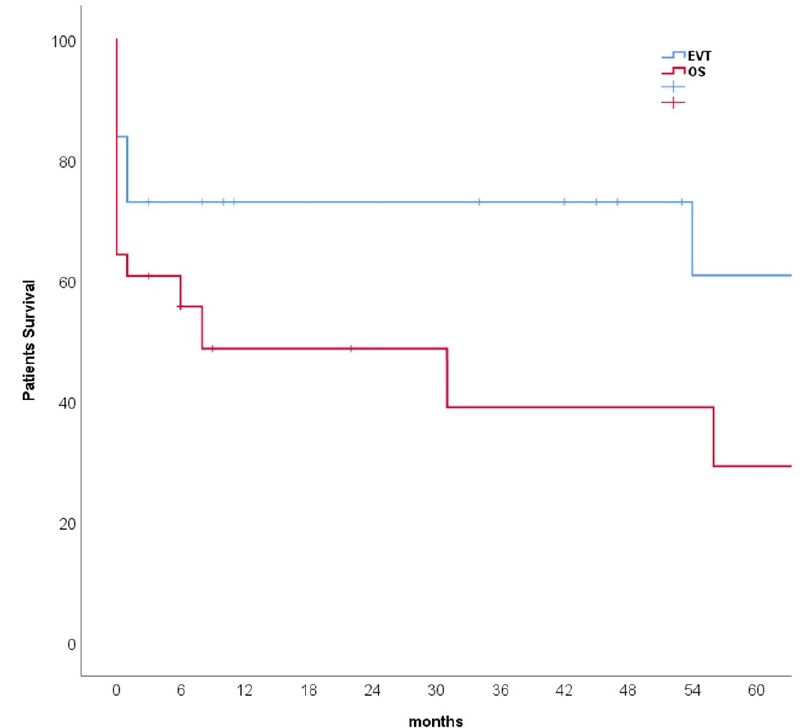
Figure 4. Kaplan–Meier survival estimates of endovascular treatment (EVT) and open surgery (OS) of the bleedings after visceral artery erosions; Kaplan–Meier log-rank test, p = 0.061.